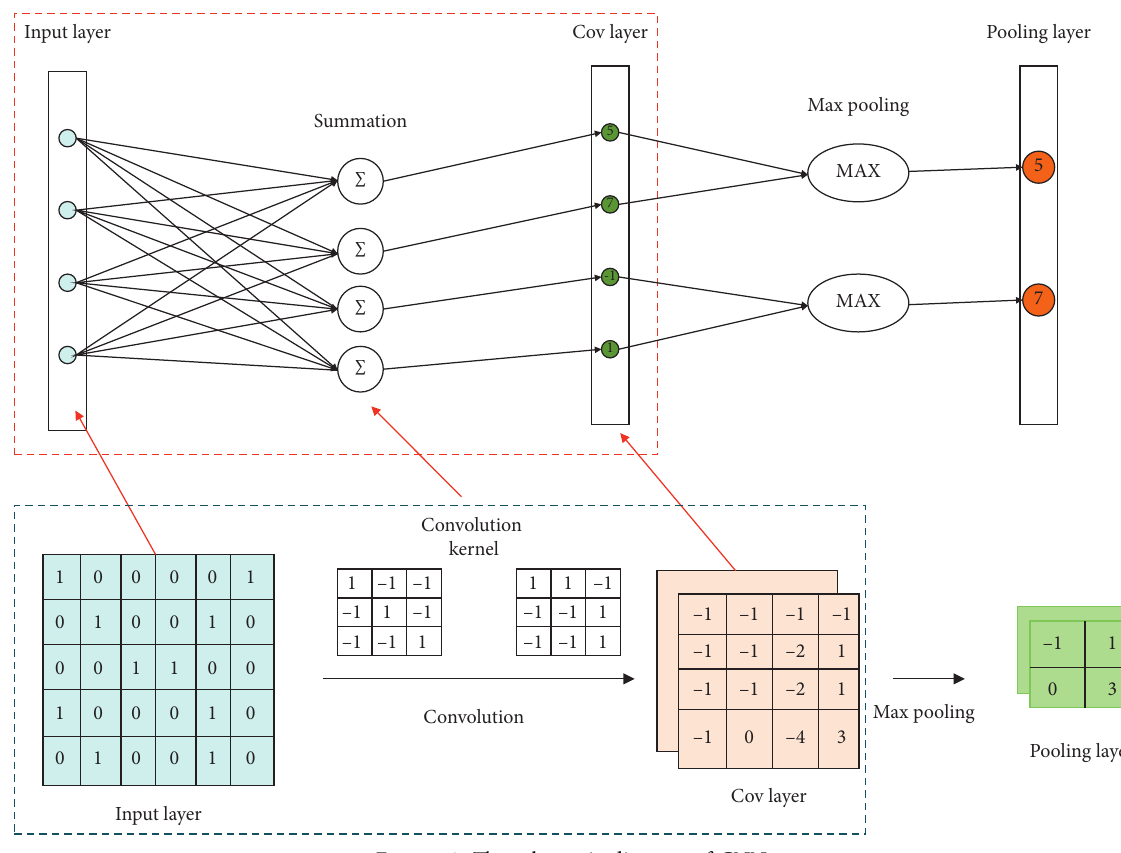
Figure 3: The schematic diagram of